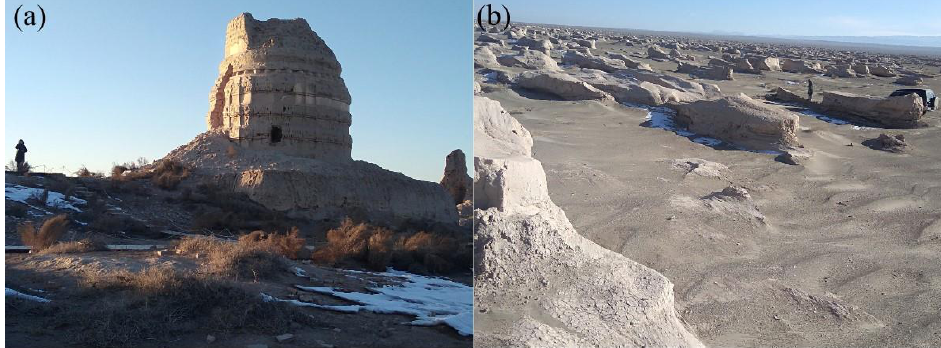
(Figure 3a) were listed as a world cultural heritage site in June 2014.